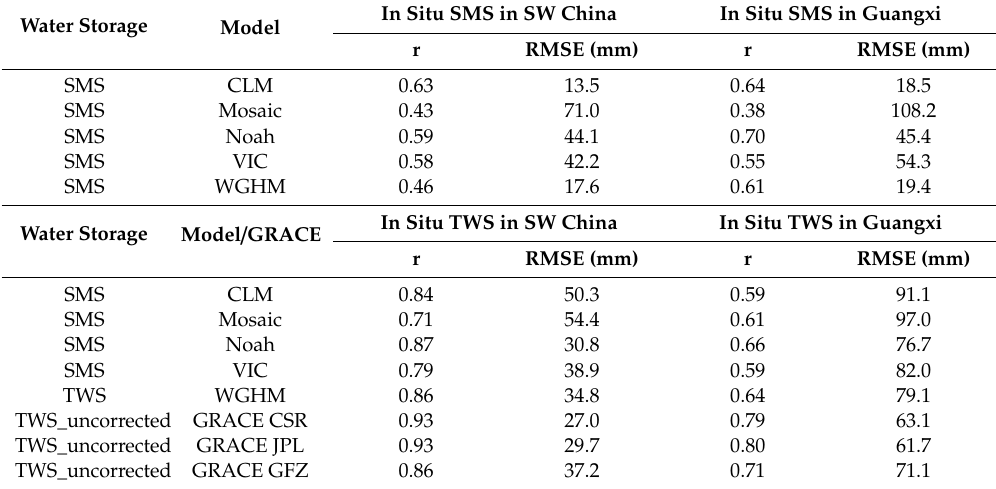
Figure 2. Comparison of simulated SMS with in situ observations of SMS. “Obs.” stands for observed SMS. Water storage anomalies are expressed as equivalent water height (EWH) in mm. Note the difference in the scale of vertical axis. Table 1. Statistics of r and root mean square error (RMSE) between in situ SMS and modelled SMS, between in situ TWS and modelled SMS, and between in situ TWS and GRACE-derived TWS. All the correlations are evaluated using a two-sided 1% level significance (i.e., p <